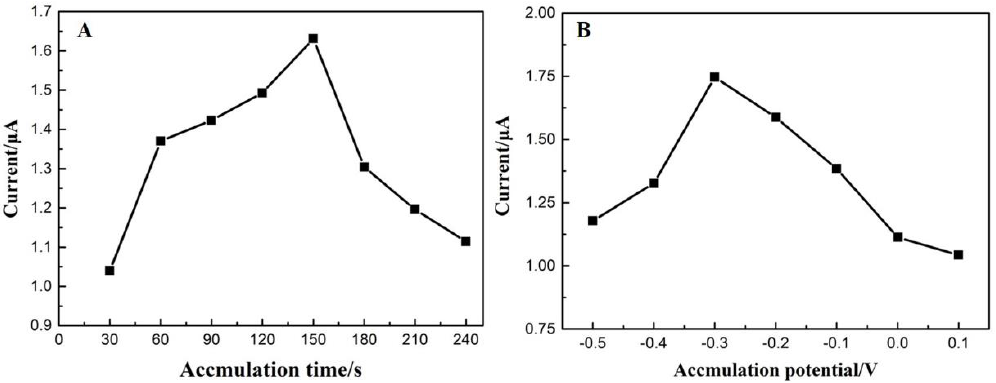
Figure 8. Influence of accumulation time ( A ) and accumulation potential ( B ) on the anodic peak currents of Allura Red.